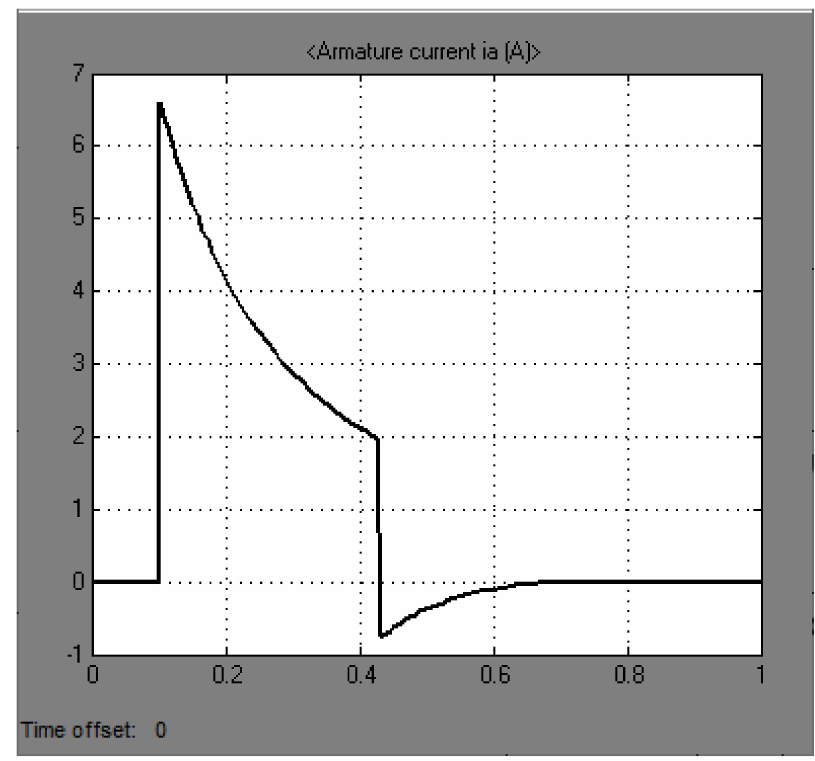
Figure 10. Stop-to-stop